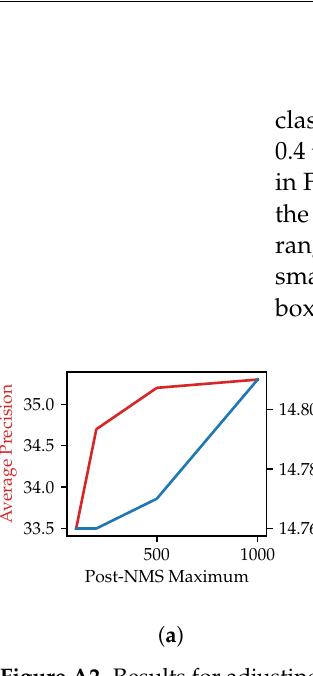
Figure A2. Results for adjusting NMS hyper parameters. ( a ) Comparing impact of maximum number of detections after NMS processing on accuracy and inference time. Reducing the number of detections to 500 is a good trade-off if the maximum performance of a model is needed. However, further reduction significantly impairs the precision with a small benefit in terms of performance. ( b ) Comparing impact of the IoU threshold of the NMS on accuracy and inference time. The impact of the IoU threshold is rather small both in terms of precision and performance if it is in a reasonable range between 0.4 and 0.7. ( c ) Comparing impact of the IoU threshold of the NMS in terms of accuracy and inference time for detecting oriented bounding boxes. Similar to the prediction of HBBs is the impact only